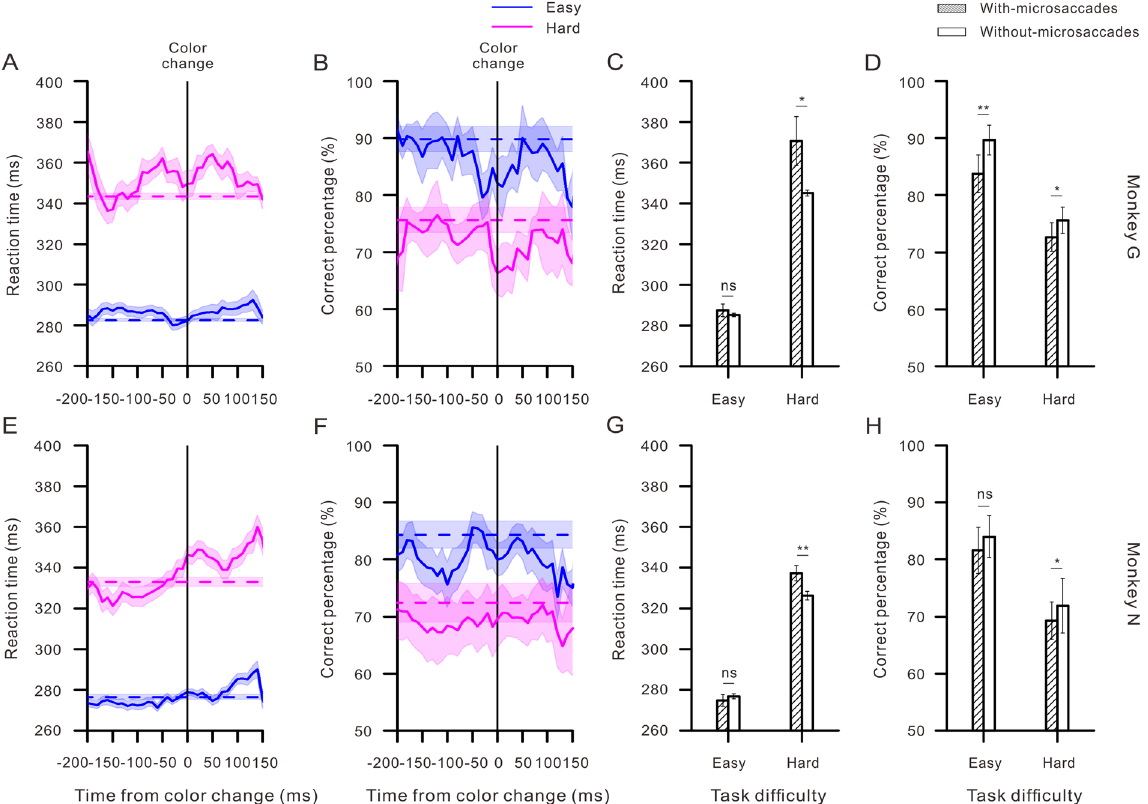
Figure 5. Monkeys’ performances when microsaccades occurred around the target color change under the easy and hard conditions. ( A , E ) The RT as a function of when microsaccades occurred around the color change onset. The vertical lines indicate the occurrence of a target color change. The horizontal dashed lines represent the average RT of all trials in which there were no microsaccades occurring within 350 ms around the target color change. There was a tendency toward longer RTs when microsaccades occurred during this period. ( B , F ) Same as in A , E but for the correct percentage. In both monkeys, microsaccades occurring around the response event were correlated with a decrease in accuracy. ( C , G ) Comparisons of the overall RT between the with- and without-microsaccade situations in both easy and hard tasks from the two monkeys. ( D , H ) Same as in C , G but for the overall accuracy. Error bars indicate SEM, and asterisks represent statistical significance ( *** p < 0.0001, ** p < 0.001, * p <